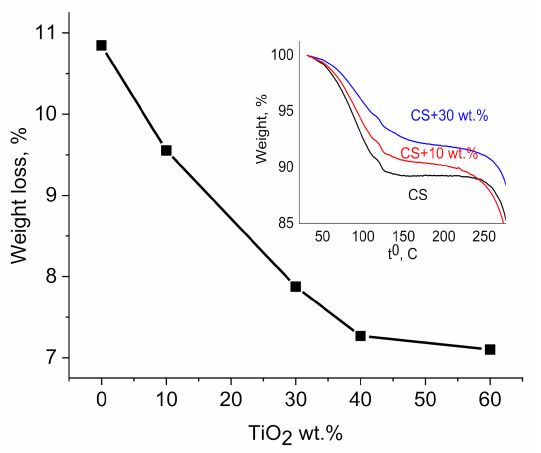
Figure 4. Dependence of weight loss in CS–TiO 2 films on NPs wt.% measured at the temperature 150 ◦ C. Insert shows TGA measurements of pure CS and CS–TiO 2 NPs films with 10 and 30 wt.% of